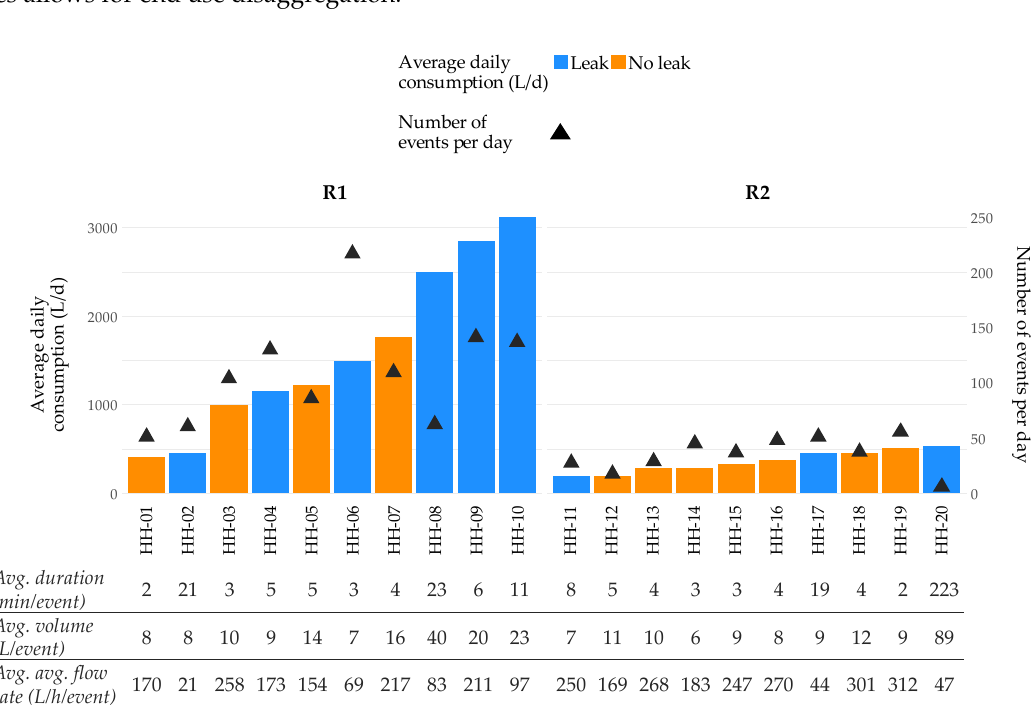
Table 1. General statistics about performance of separation process.